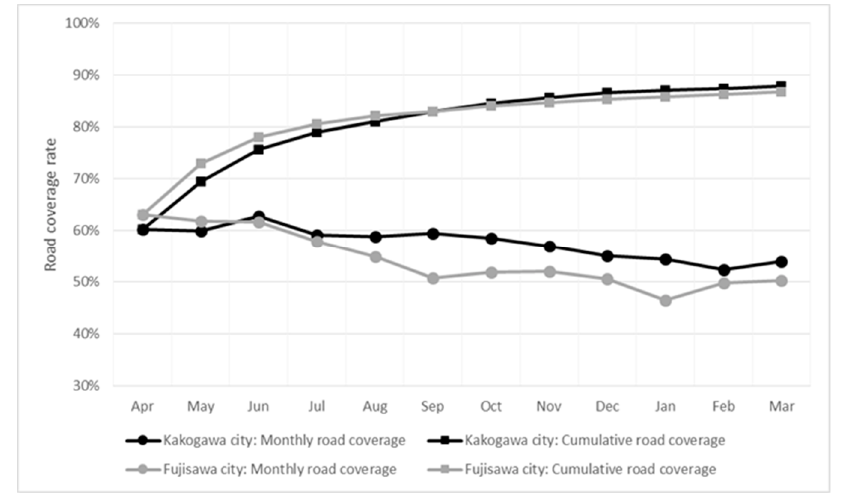
Figure 2. Road coverage curve of approximately 150 public vehicles and the similarity between cities.